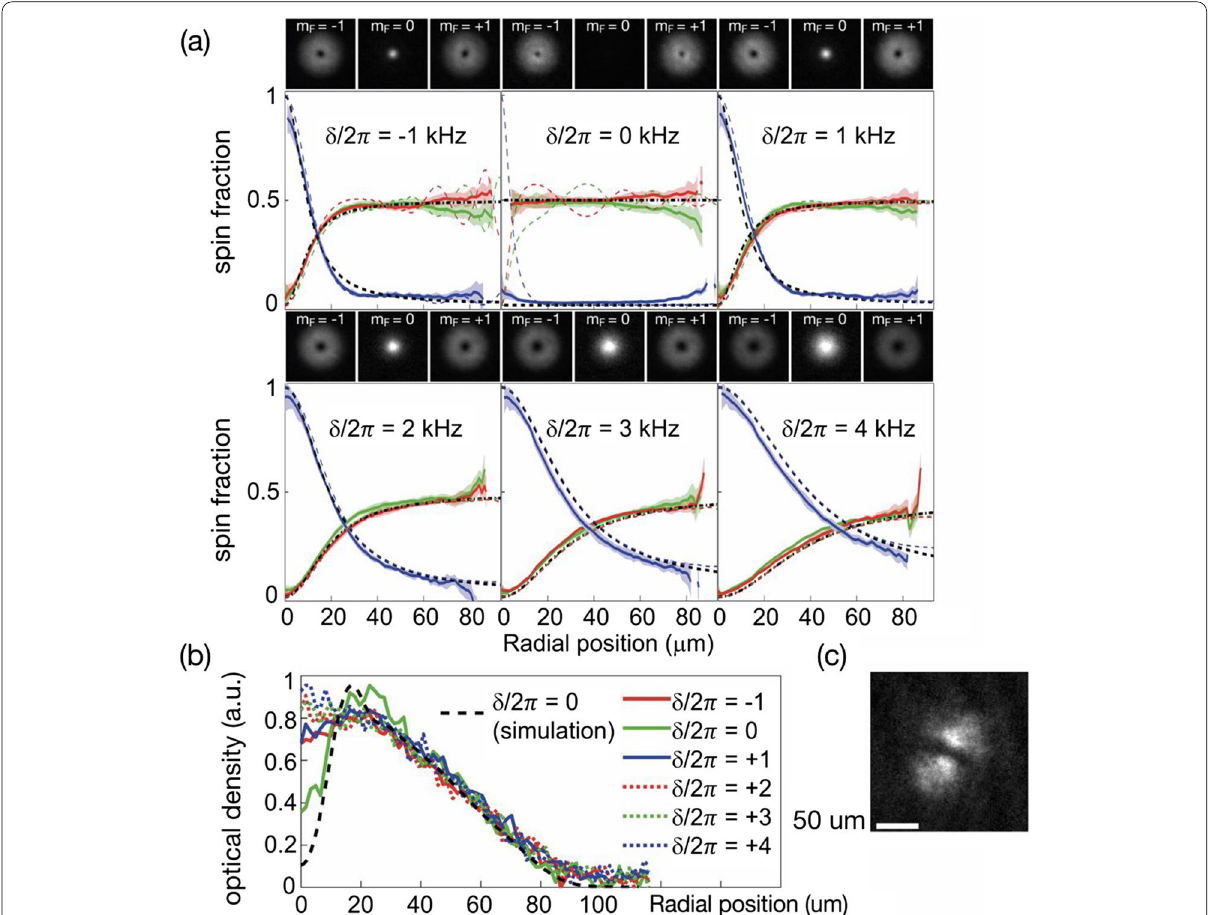
ξ 0 . The images are taken after 24 ms | � m F for different Raman detunings. The blue, red, and green | � 0 . Adapted from Ref. 1 components at δ |± � =